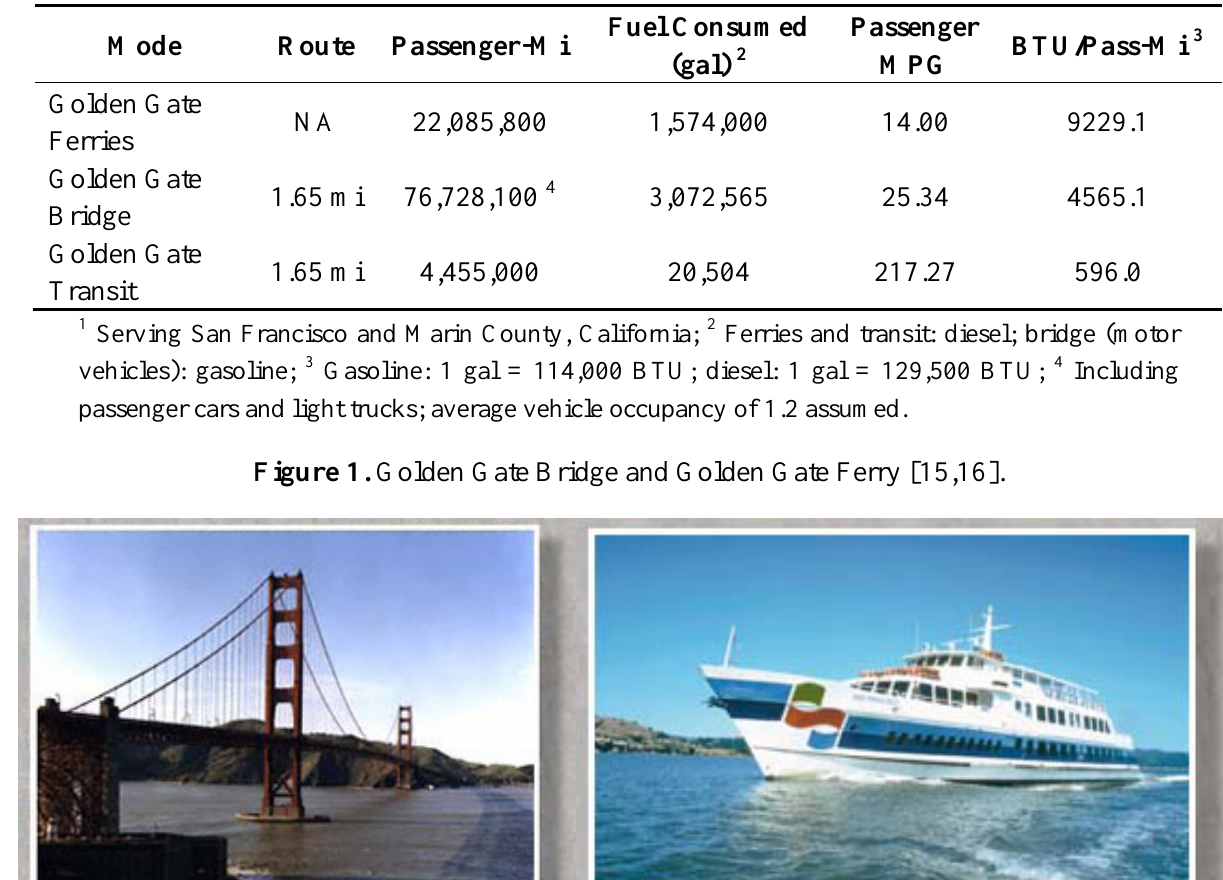
Table 2. Year 2008 Golden Gate Ferry and Golden Gate Bridge Statistics 1 .